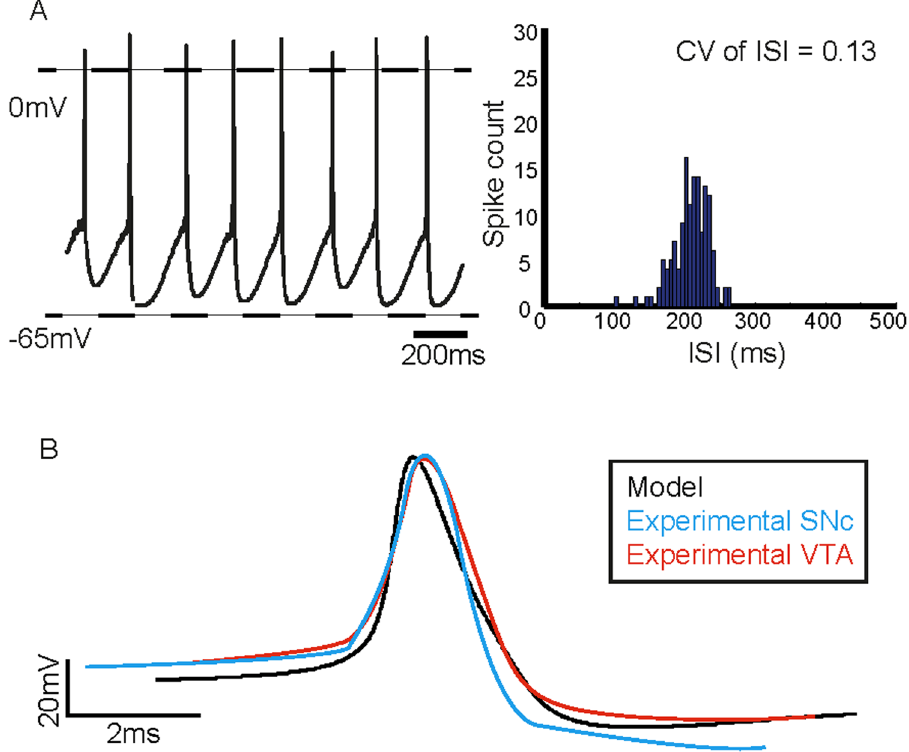
Figure 2. Spontaneous spike train and action potential characteristics obtained from simulations. ( A ) The in silico dopamine neuron fired spontaneously at a rate of 3.6 Hz and the CV of ISIs is equal to 0.13. The spike train was characterised by slow depolarisation preceding the spike, followed by a pronounced post-spike AHP. ( B ) Average action potential waveforms obtained from the model superimposed with those obtained from the SNc and VTA. The average waveforms were aligned at the point of maximum rate of rise. (Experimental waveforms adapted from ref.